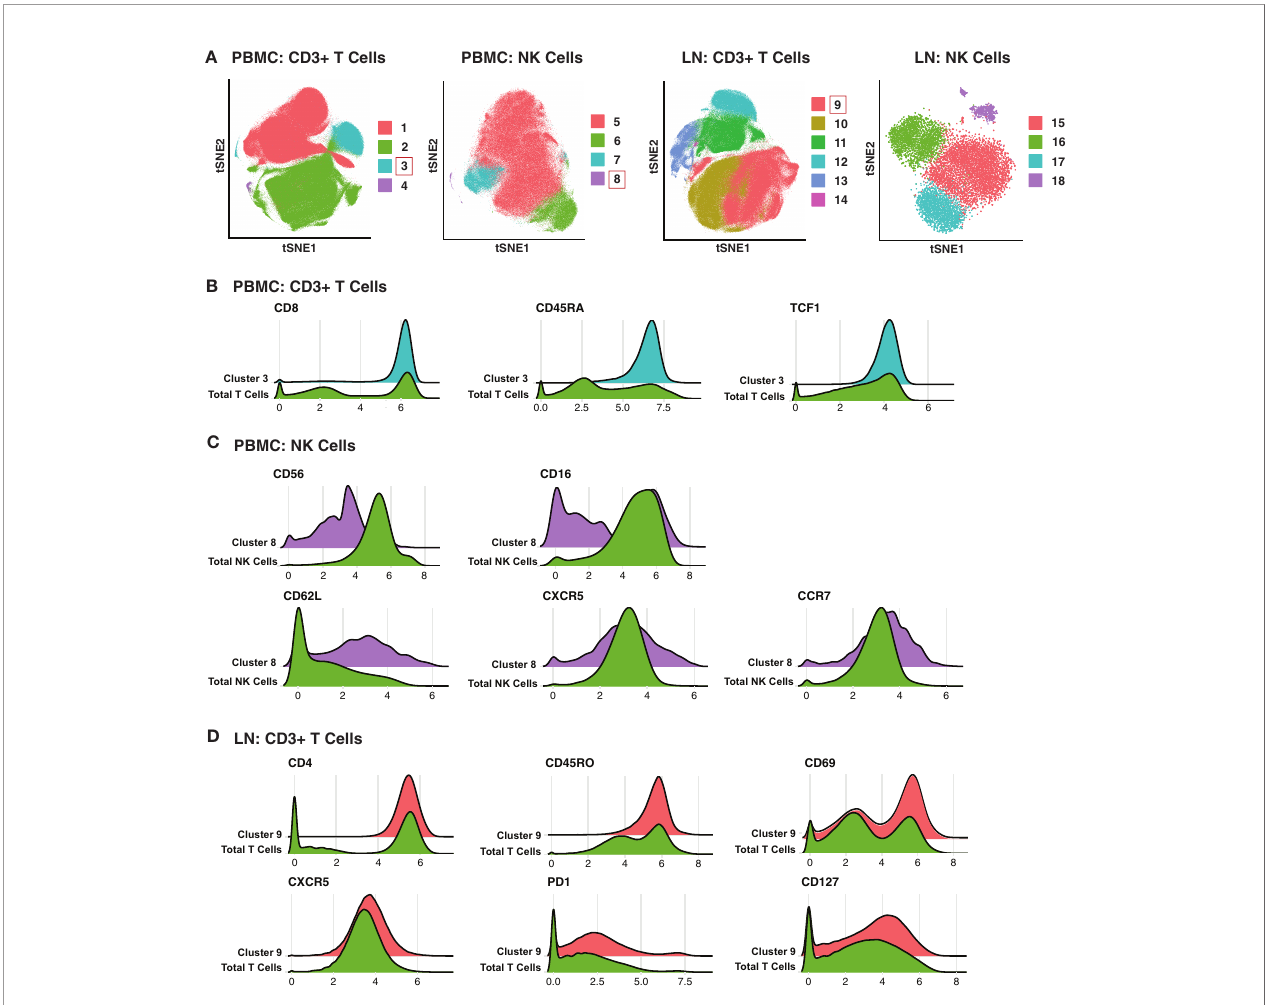
FIGURE 2 | Clusters of T and NK cells associated with acutely treatment of HIV. (A) tSNE visualization of T and NK cell clusters from PBMCs and LNs. Clusters signi fi cantly enriched in the acutely-treated group are boxed in red. (B) Cluster 3 of blood T cells was enriched in the acutely-treated group relative to controllers (P < 0.0001) and the chronically-treated group (P < 0.009). Cells in Cluster 3 expressed relatively high levels of CD8, CD45RA, CD27, CCR7, and TCF1. (C) Cluster 8 of blood NK cells was enriched in the acutely-treated group relative to chronically-treated group (P < 0.05). Cells in Cluster 8 expressed low levels of CD56, and approximately half of them were CD16+. Cluster 8 also included cells expressing high levels of lymph node-homing receptors CD62L, CCR7, and CXCR5. (D) Cluster 9 of LN T cells was enriched in the acutely-treated group relative to controllers (P < 0.03) and the chronically-treated group (P < 0.0001). Cluster 9 corresponded to CD4+ T cells expressing high levels of the T resident memory (Trm) marker CD69, the T follicular helper (Tfh) markers PD1 and CXCR5, and the alpha chain of the IL7 receptor CD127. A generalized linear mixed model (GLMM) was used to estimate the association between cluster membership and group (controllers, acutely-treated, or chronically-treated). The log odds ratio was retrieved from the coef fi cient estimate of each variable. All p-values were adjusted using the FDR, and a threshold of 0.05 was used to determine signi fi